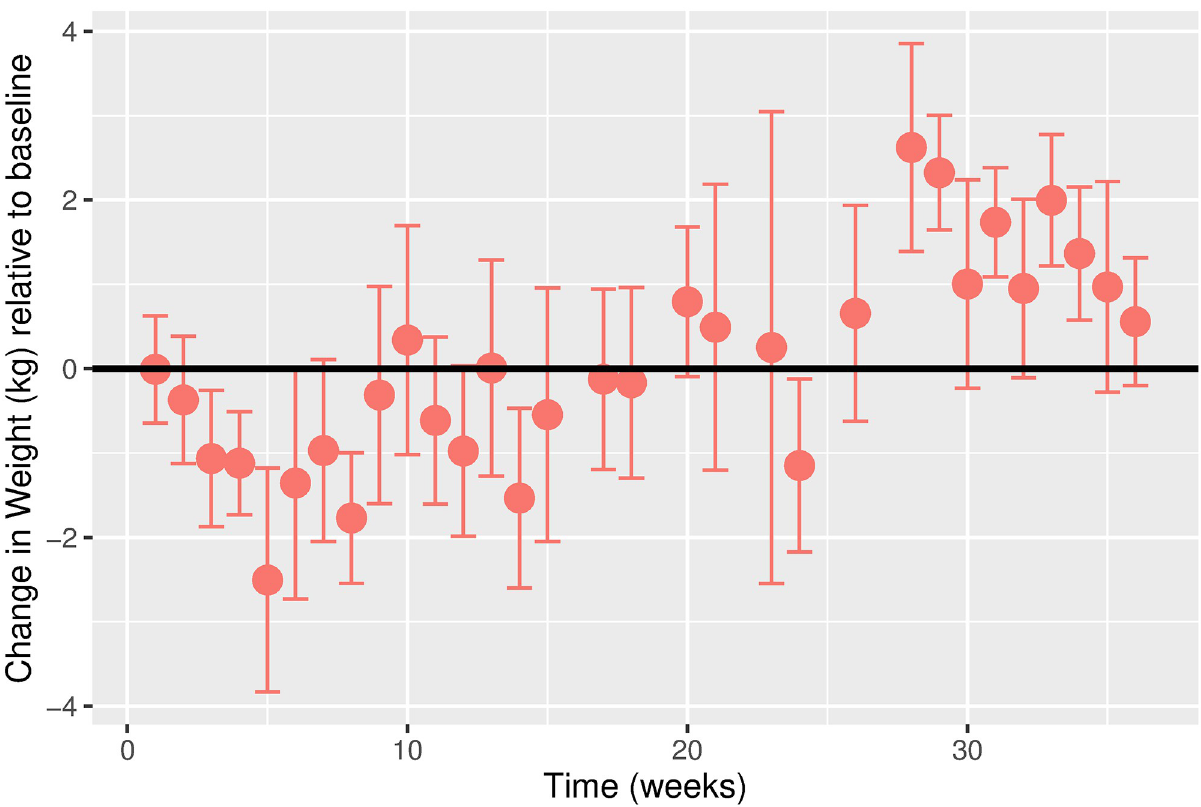
Fig 3. Estimated change in weight (kg) relative to baseline over time in weeks for males. Error bars represent the 95% confidence intervals. Change in Weight (kg) relative to baseline. Time (weeks). Error bars represent the 95% confidence intervals.